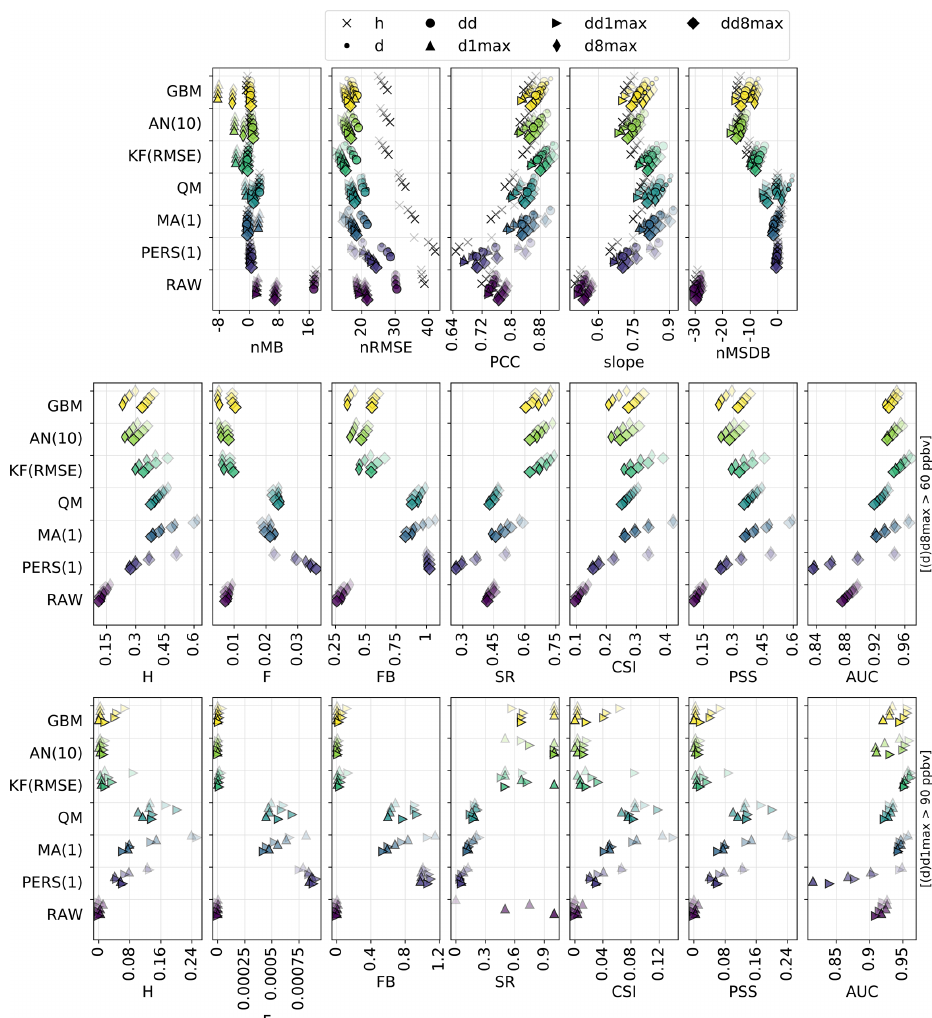
Figure 3. Statistical performance of RAW and MOS-corrected CAMS O 3 forecasts for continuous metrics (top panels) and categorical metrics related to the exceedance of the target (intermediate panels) and information threshold (bottom panels). The different symbols depict results obtained at different timescales (h: hourly; d: daily mean; d1max / dd1max: daily 1h maximum; d8max / dd8max: daily 8h maximum). In each panel, results are shown for the different methods (each with a given color). The overlaying symbols of decreasing transparency show the results at the different lead days from D + 1 (most transparent) to D + 4 (most opaque). Metrics: normalized mean bias (nMB in %), normalized root mean square error (nRMSE in percent), Pearson correlation coefficient (PCC), slope (unitless), normalized mean standard deviation bias (nMSDB in percent), hit rate ( H ), false alarm rate ( F ), frequency bias (FB), success ratio (SR), critical success index (CSI), Peirce skill score (PSS), area under the ROC curve (AUC). See Sect. 2.4 and 2.5 for details on timescales and metrics,